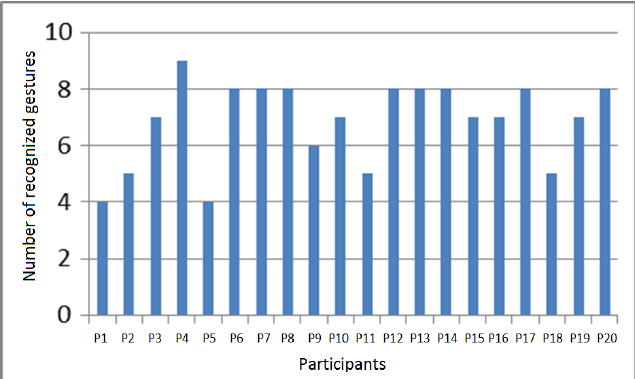
Fig. 7. Number of correct recognized gestures